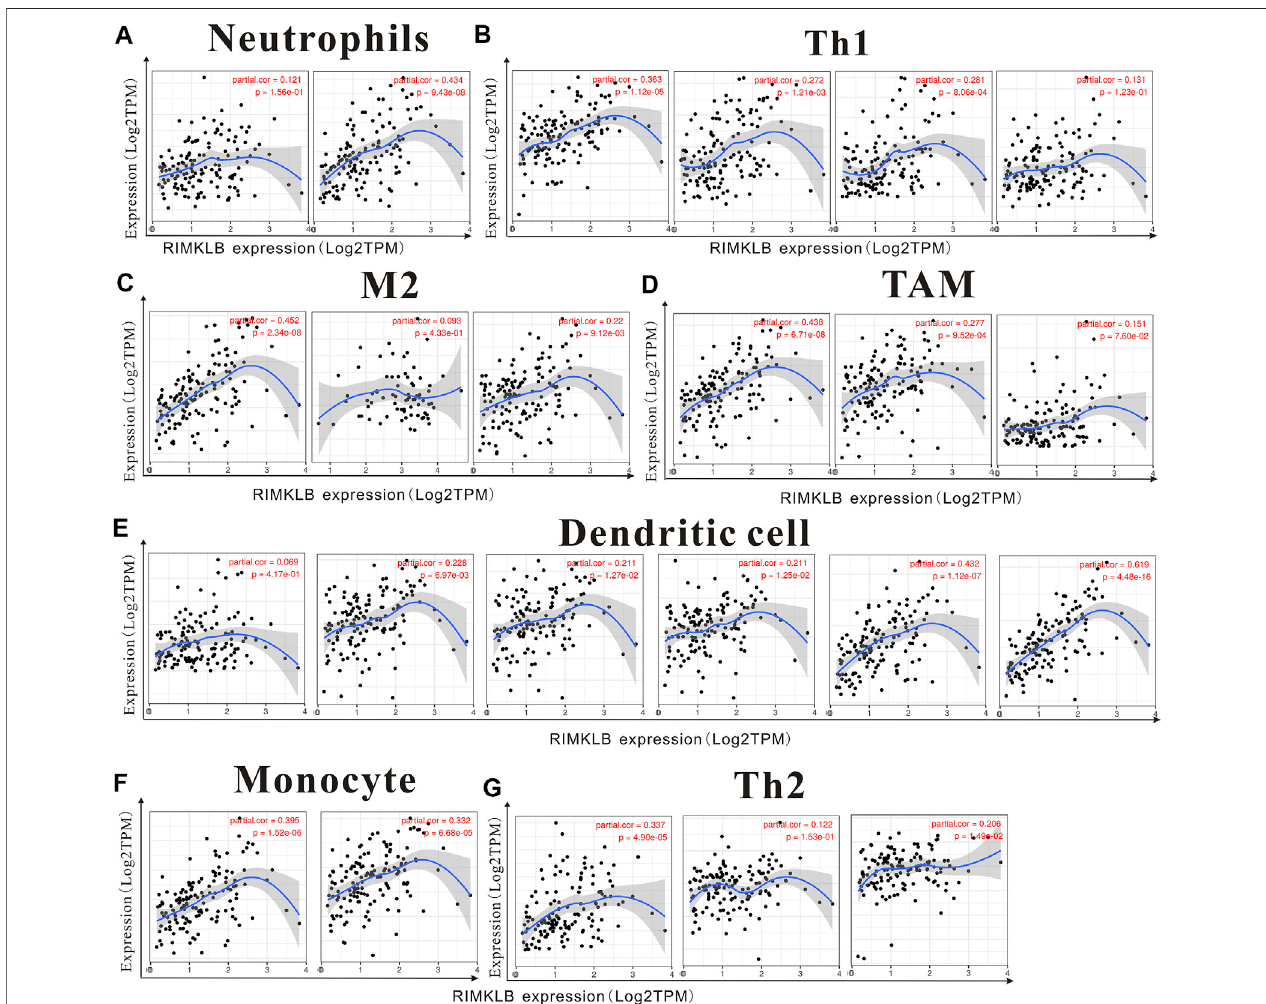
FIGURE 8 | The expression of RIMKLB and the correlation with immune in fi ltration in READ (recutm adenocarcinoma). Markers include ITGAM, and CCR7 of Neutrophils;TBX21,STAT1,STAT4,andTNFofTh1;CD86andCSF1Rofmonocytes;CD163,andVSIG4ofM2macrophages;CCL2,CD68,andIL10ofTAMs(tumor- associated macrophages); HLA-DPB1, HLA-DRA, HLA-DPA1, CD1C, NRP, and ITGAX of Dendritic cell; GATA3, GATA6, and GATA5A of Th2. (A – G) Scatterplots of correlationsbetweenRIMKLBexpressionandgenemarkersofNeutrophils (A) ,Th1 (B) ,andM2macrophages (C) ,TAMs (D) ,Dendriticcell (E) ,monocytes (F) ,and Th2 in